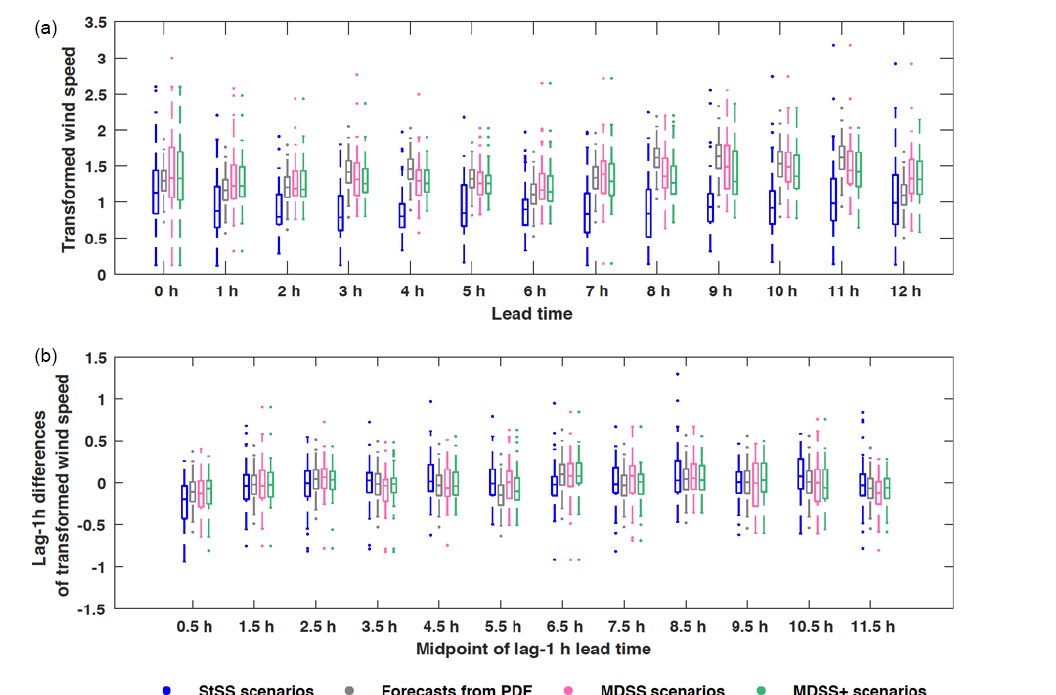
Figure 7. Box plots of (a) the forecast marginal distributions of transformed wind speed (gray boxes) and (b) forecast lag 1h wind speed differences (gray boxes) for 00:00UTC forecast initialization on 28 March 2015 at the PNW tower location. Distributions of transformed wind speed and lag 1h differences in transformed wind speed from the 50 historical scenarios used by the StSS (blue boxes) and selected by the MDSS (pink boxes) and MDSS + (green) methods are also shown. The box plots display the interquartile range (rectangle region), the median (middle line within rectangle), outliers (dots), and values outside the interquartile range but not considered outliers (lower and upper whisker) of the distributions. Outliers are values more than 1.5 times the interquartile